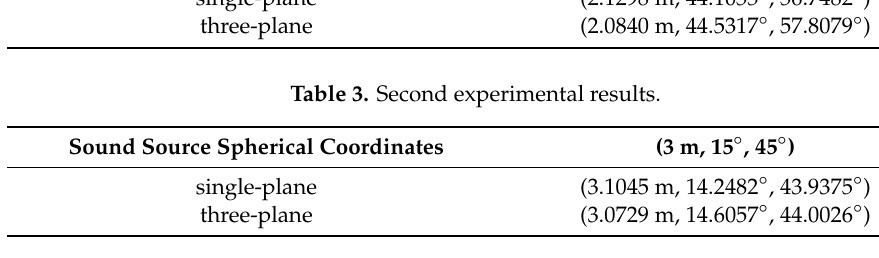
Table 4. Third experimental results.